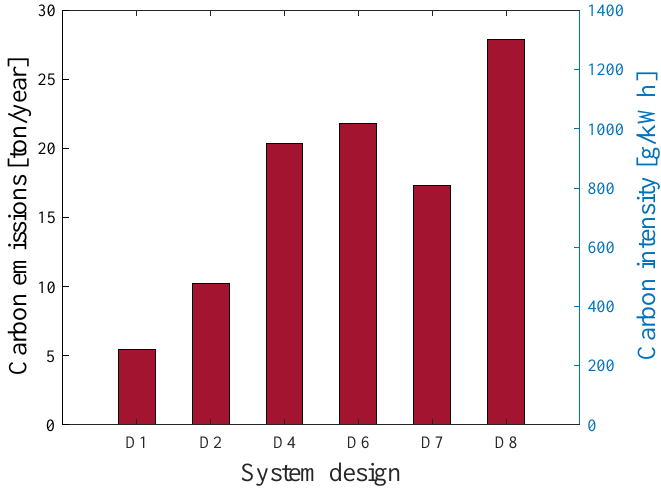
Figure 8. Diesel generator carbon emissions and system carbon intensity.